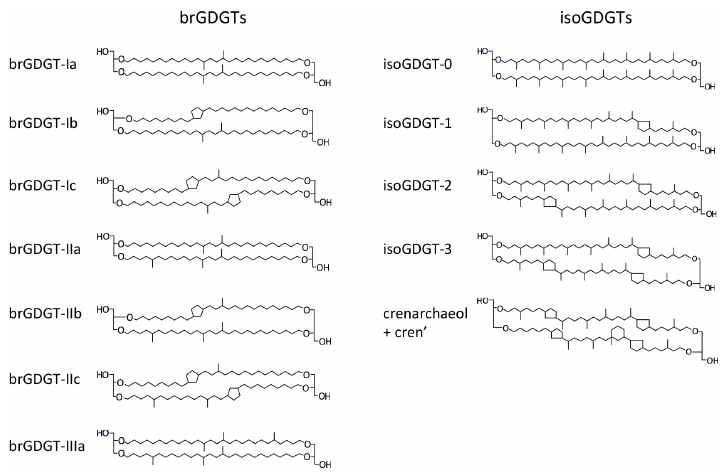
Figure 1. Molecular structures of the brGDGTs and isoGDGTs monitored during the incubation